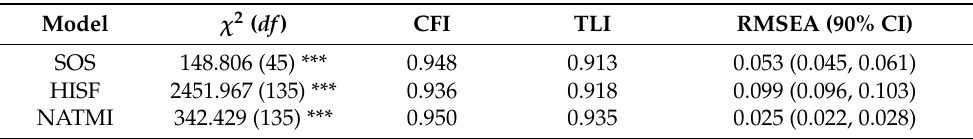
Table 3. CFA fit indices for SOS, HISF, and NATMI.